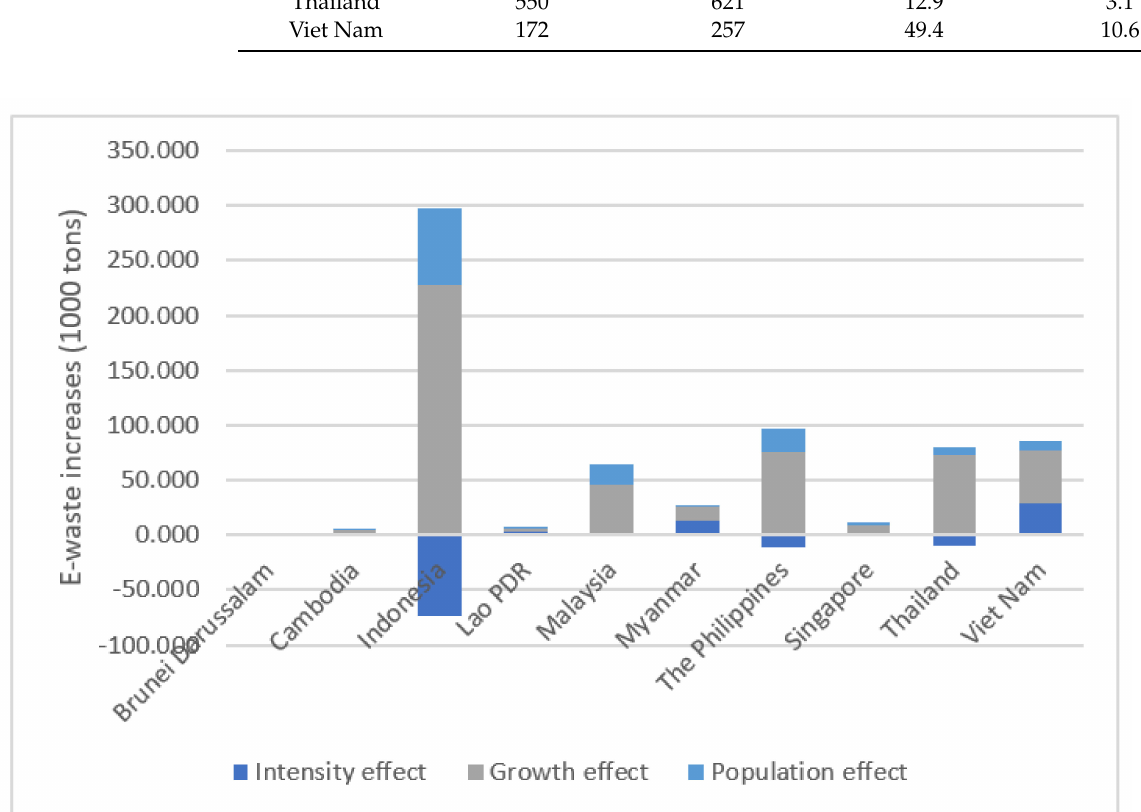
Figure 2. E-waste increases by effect (Additive,